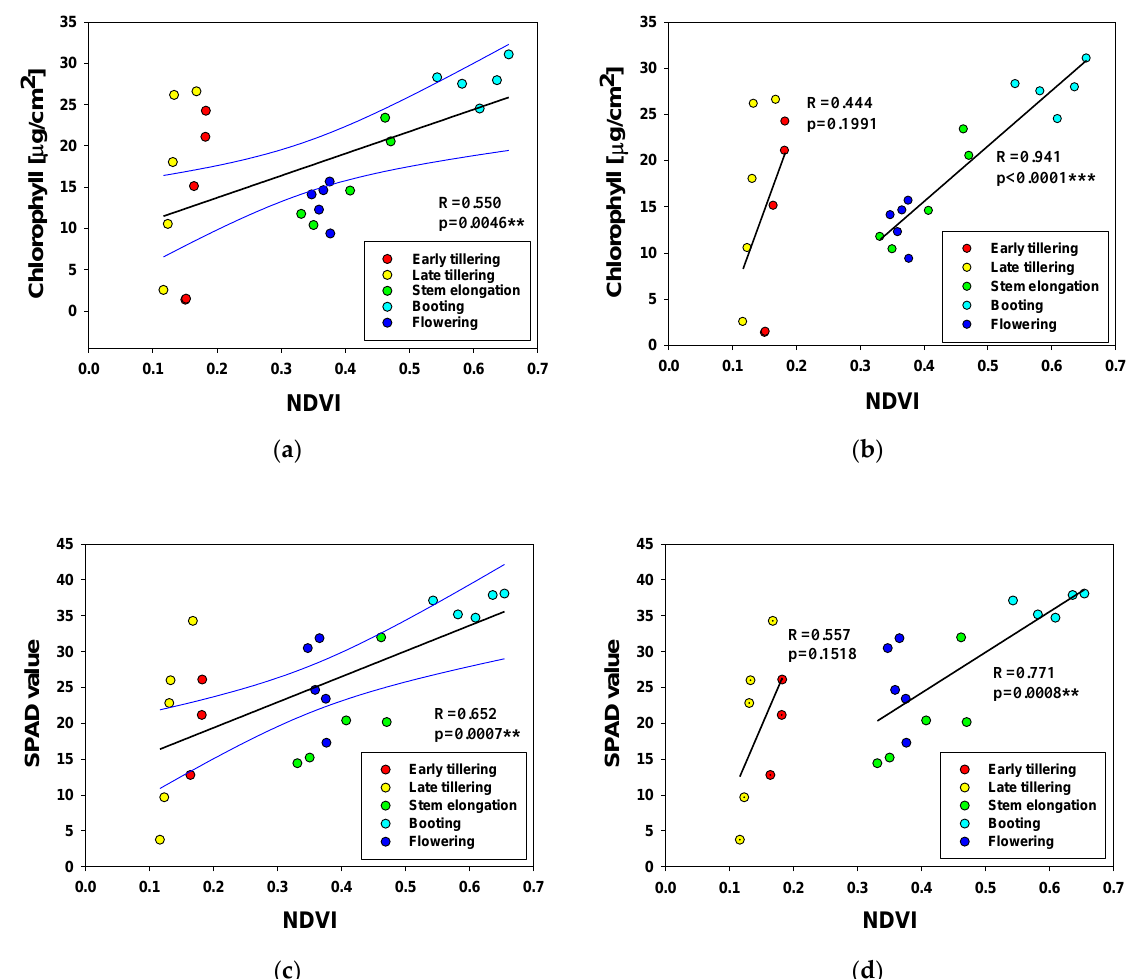
Figure 10. Correlation between the NDVI and ( a ) leaf chlorophyll content for all growth stages; ( b ) leaf chlorophyll contents for the earlier and later growth stages; ( c ) SPAD value for all growth stages; ( d ) SPAD value for the earlier and later growth stages. The blue line refers to the 95% confidential interval. R and p refer to the Pearson correlation coefficient and p -value, respectively (* p < 0.05; ** p < 0.01; *** p < 0.001).